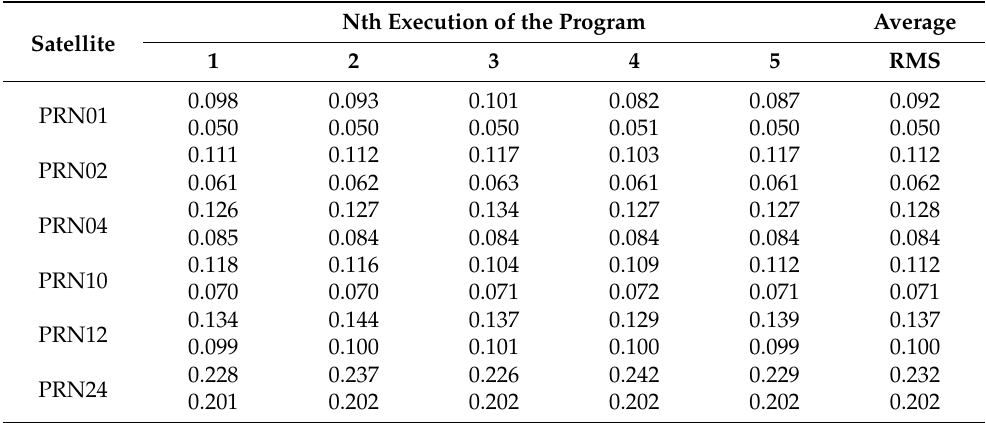
Table 5. Prediction precision of the BP model and the HPSO-BP model for five forecasts of six satellites (60-min forecasting) (Unit: